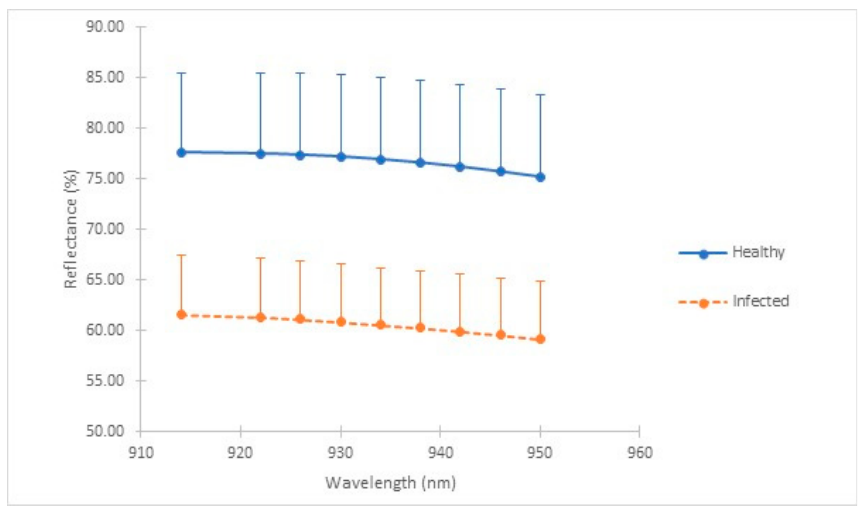
Figure 2. Graph of reflectance (%) for each wavelength (nm) for healthy and infected seedlings.